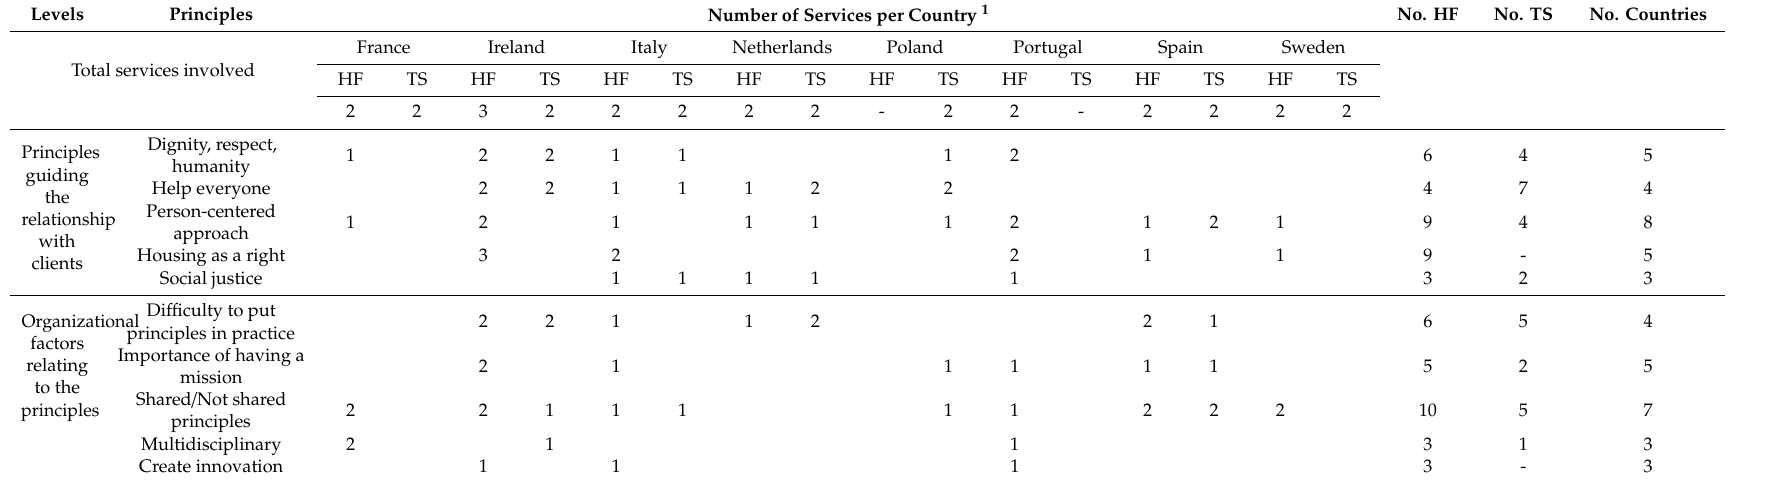
Table 5. Service’s principles emerged within HF and TS programs in eight European